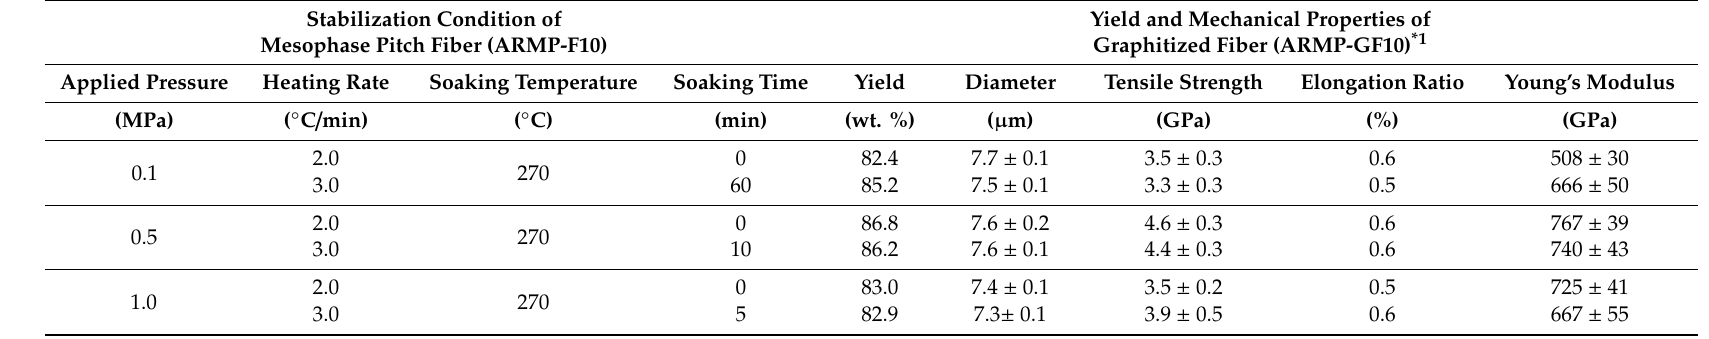
Table 3. The yields and mechanical properties of graphitized fibers (Heating rate of stabilization: 2.0 and 3.0 ◦ C / min, soaking time: 0–60 min). ARMP-GF, ARMP graphitized